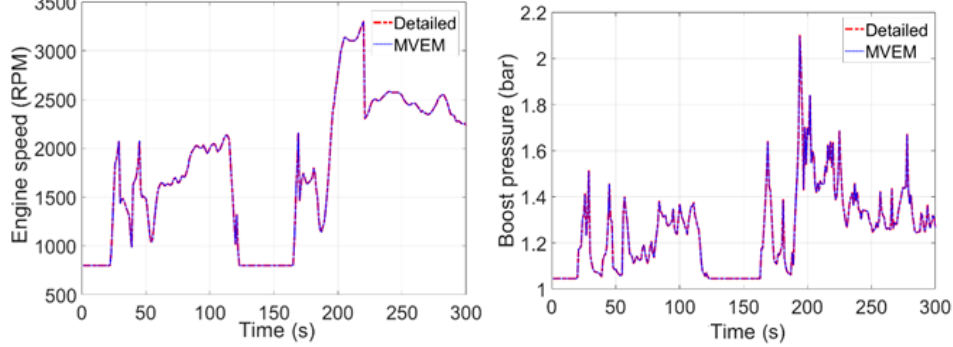
Figure 5. The first 300 s engine speed and boost pressure comparison for the US EPA FTP-72 (Federal Test Procedure) drive cycle.